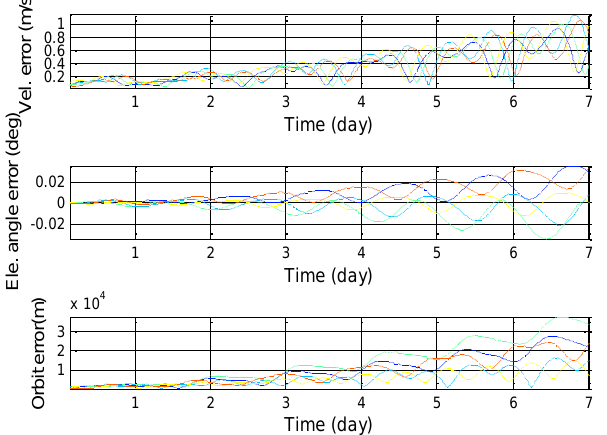
Figure 18. BDS GEO almanac using period test for one week.